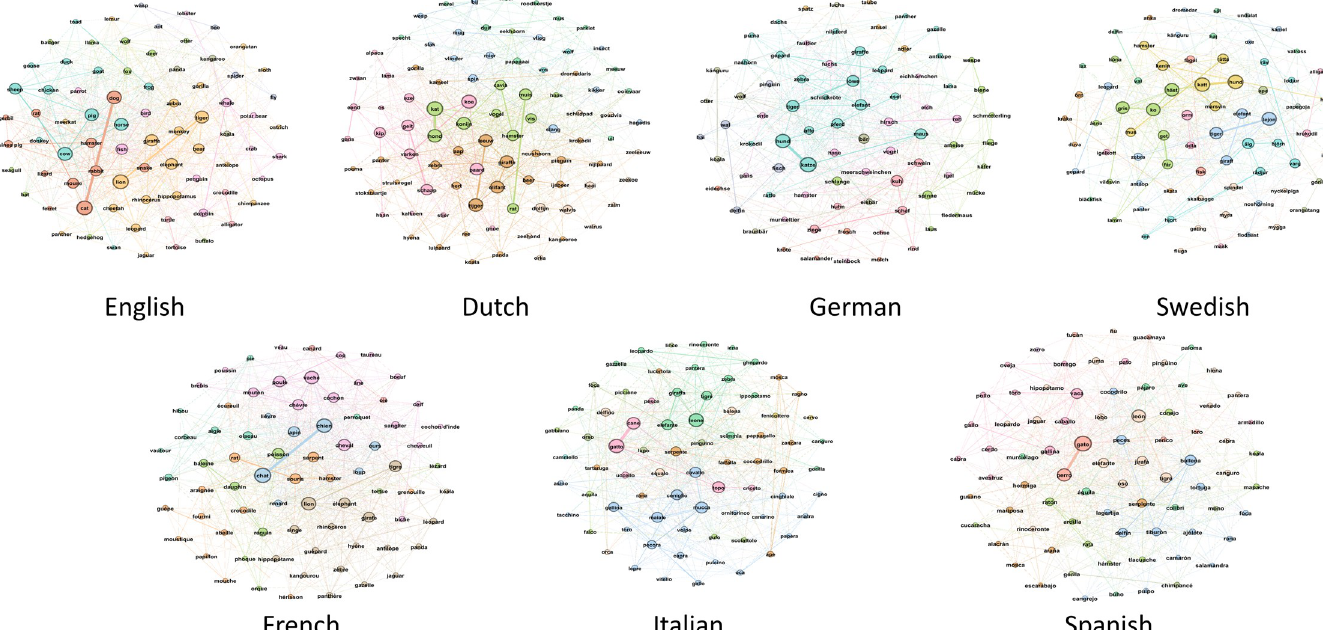
PLOS ONE | https://doi.org/10.1371/journal.pone.0239858 October 14,